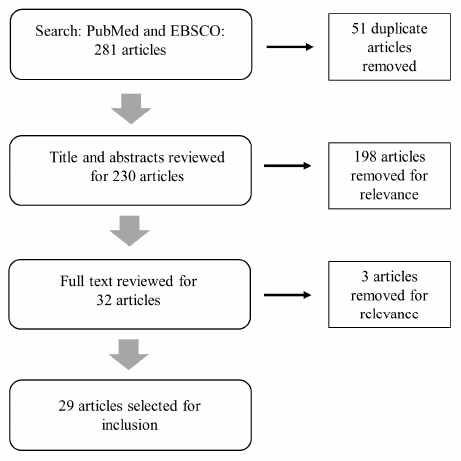
Figure 1. Literature search process.